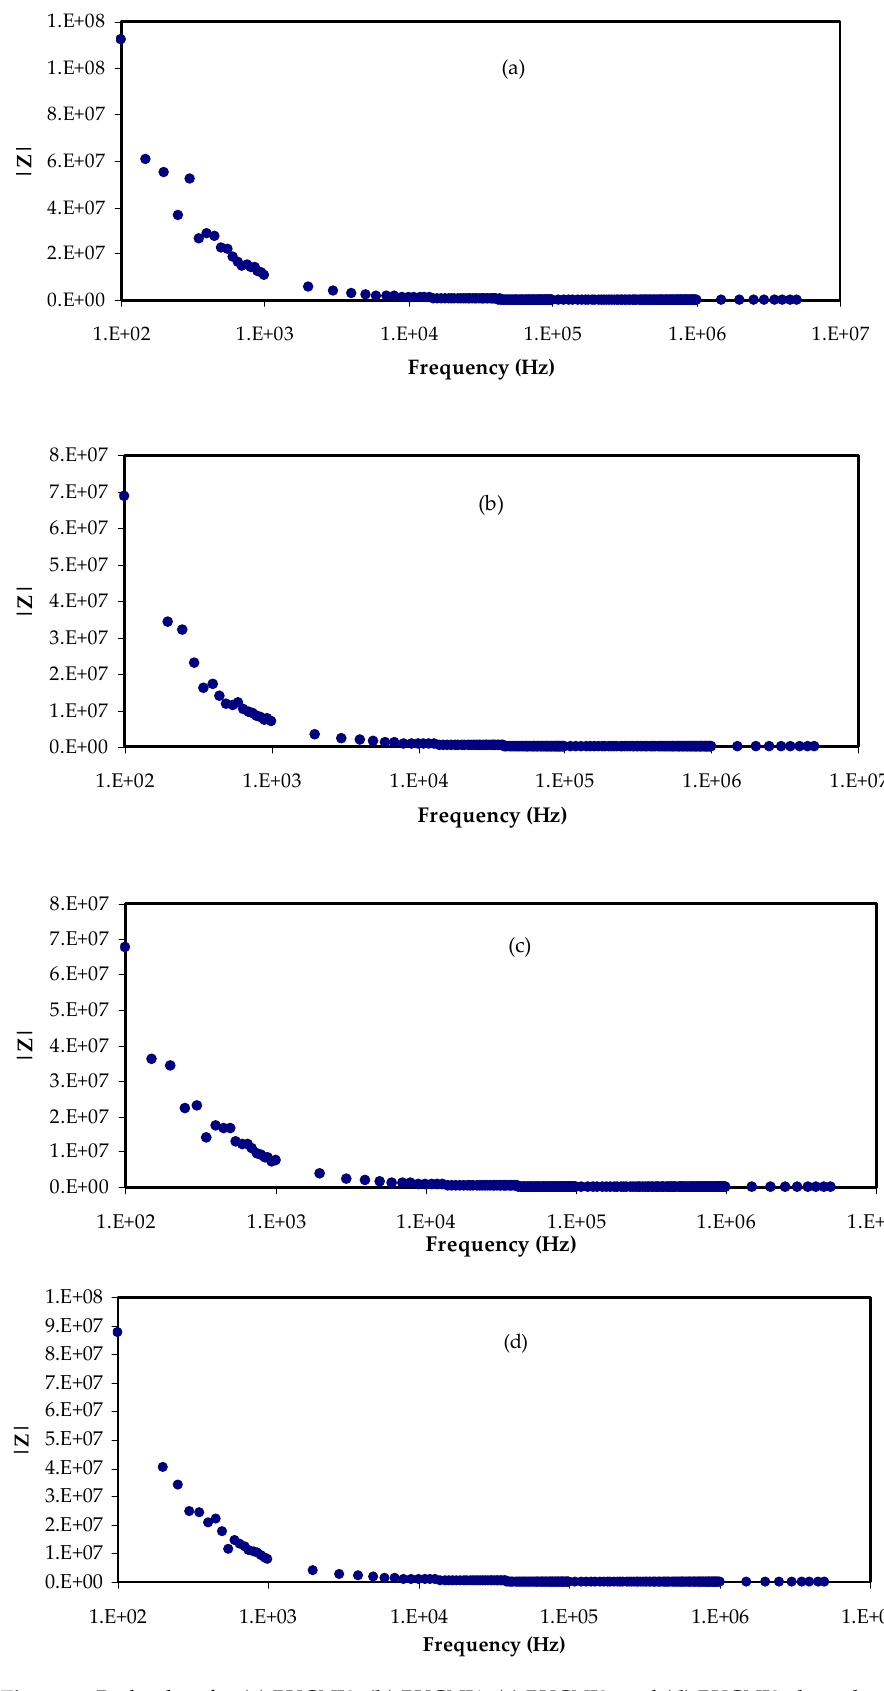
Figure 4. Bode plots for ( a ) PVCNI0, ( b ) PVCNI1, ( c ) PVCNI2, and ( d ) PVCNI3